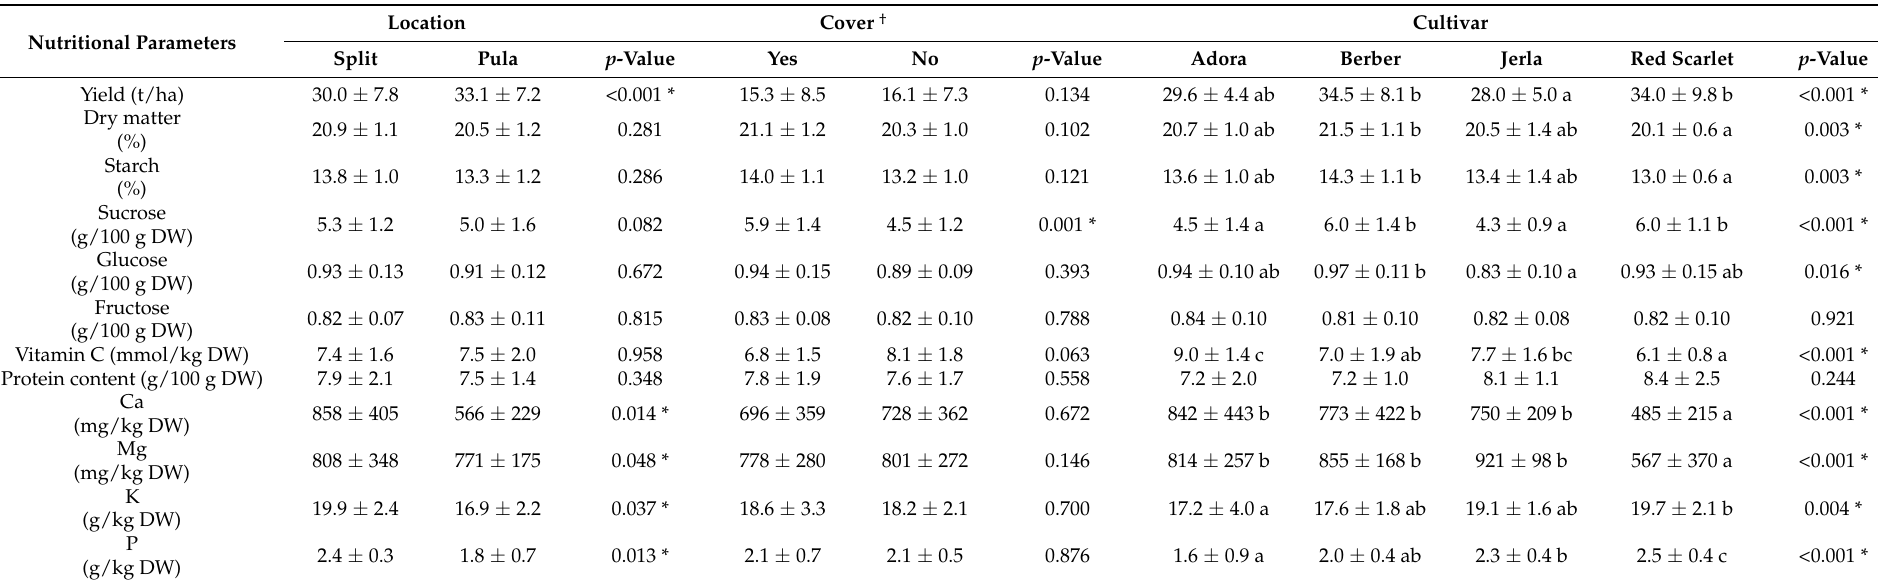
Table 1. Nutritional properties of potato tubers affected by location, plant cover and cultivar in the first year of growing. Nutritional